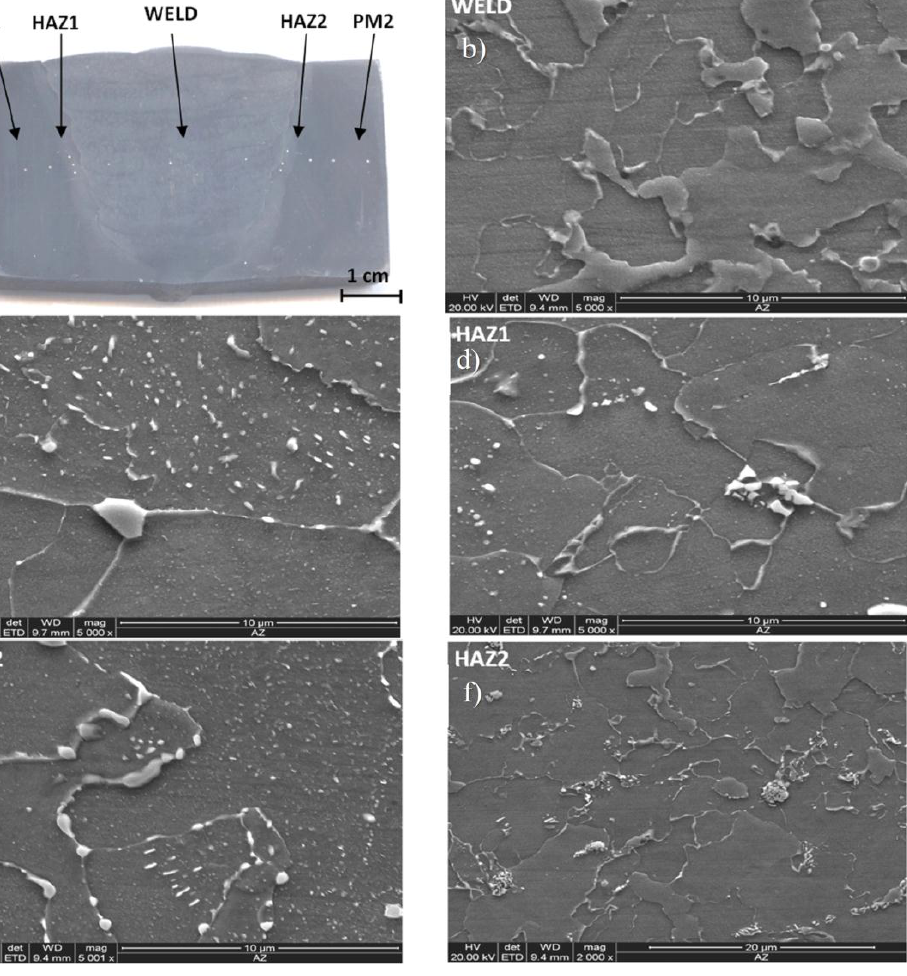
Figure 3. Structure of the material of components of the repair welded joint marked ZS1 made from 14MoV6-3 steel after 169,000 h service; microstructure investigation locations ( a ): parent material marked ( c ) PM1, ( e ) PM2; heat affected zone marked ( d ) HAZ1,( f ) HAZ2; weld marked ( b ) WELD.